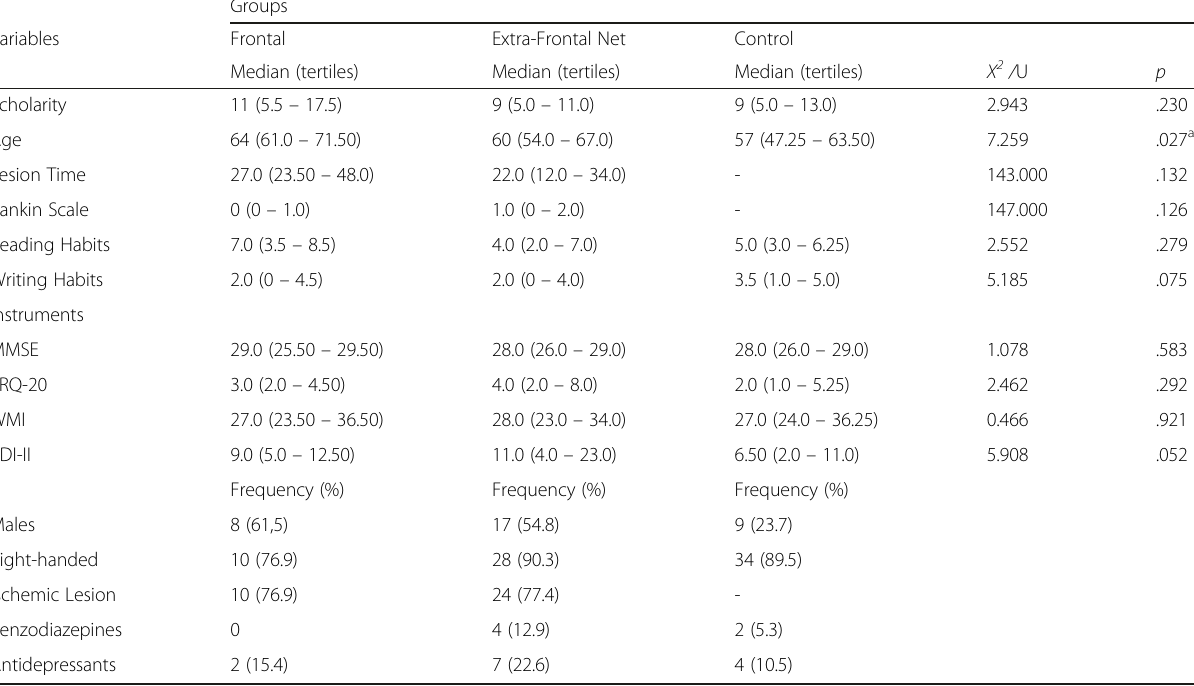
Table 1 Comparison among the three groups, regarding medians and frequencies of controlled